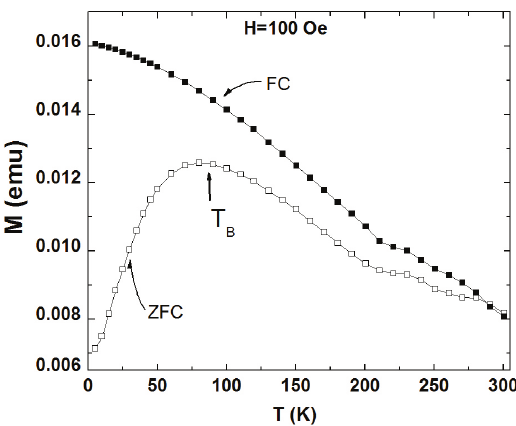
Figure 4. Curve fitting ZFC and FC measurements at 100 Oe.